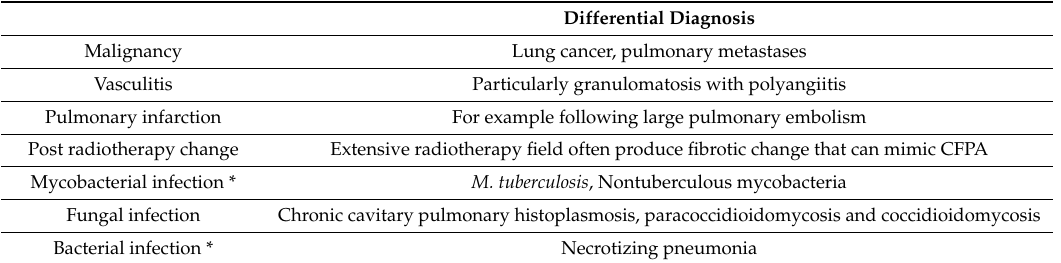
Table 3. Differential diagnosis of CPA. * Commonly co-existent with CPA.